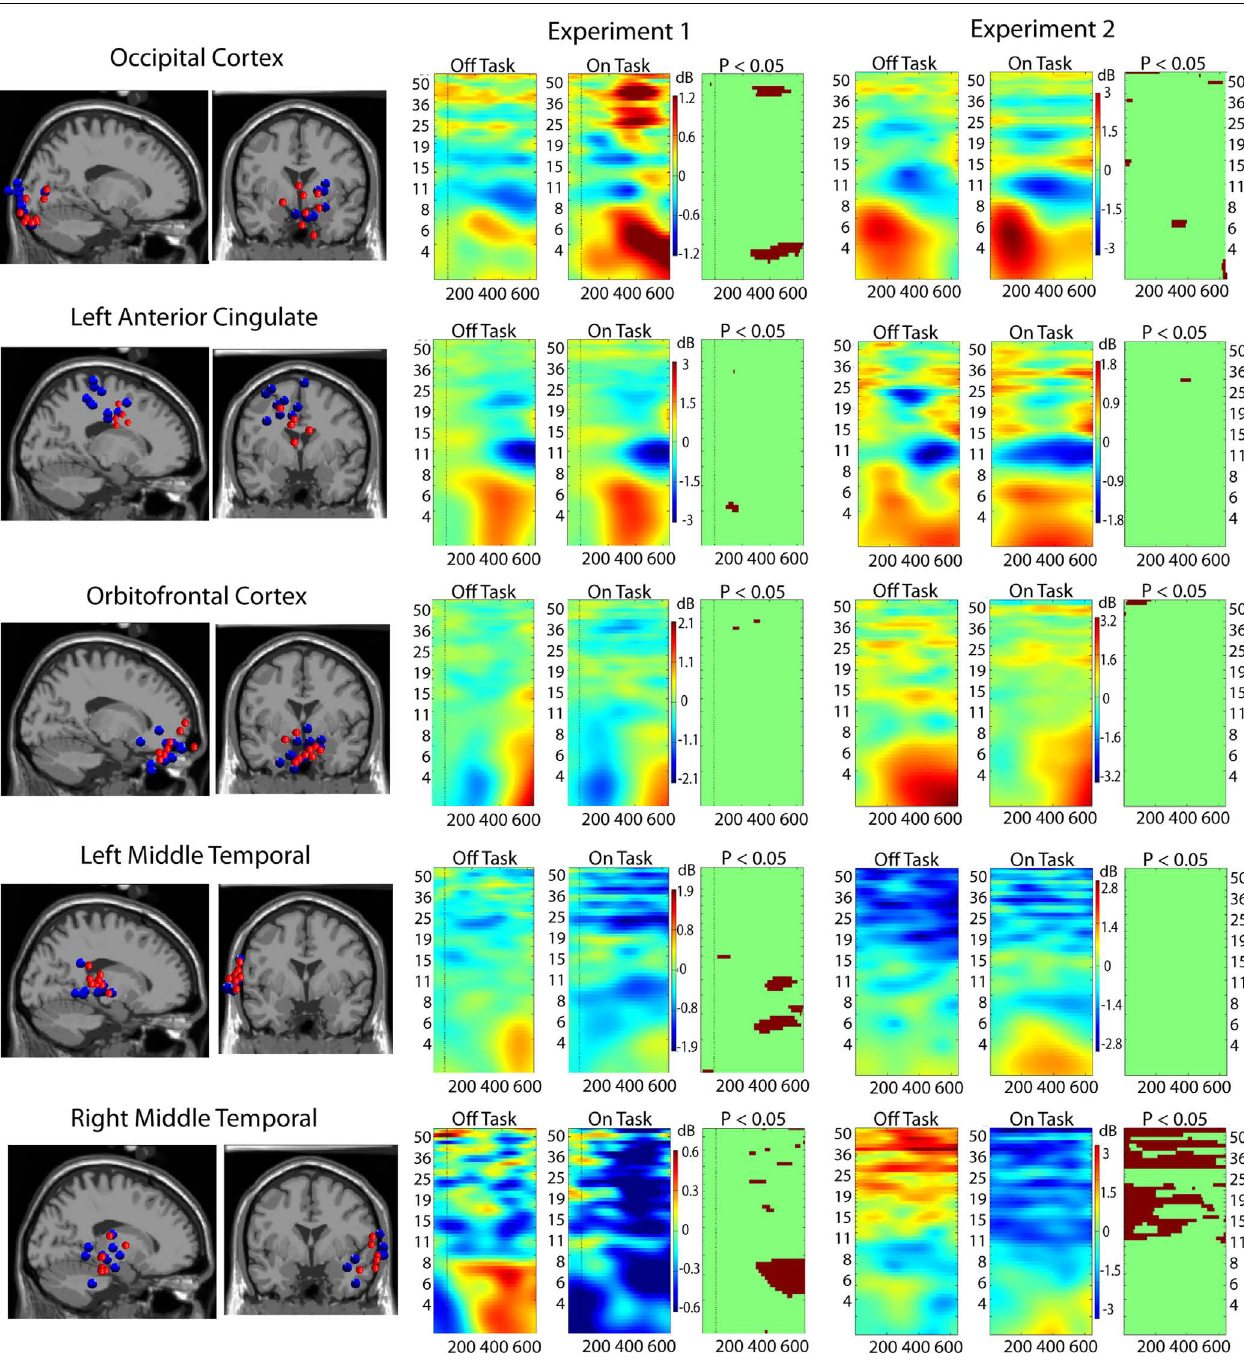
FIGURE 3 | Event-related spectral perturbation (ERSP) results for ICs localized to five critical brain regions. Leftmost columns show the locations in the brain of clusters of ICs from the two experiments: Experiment 1 in red